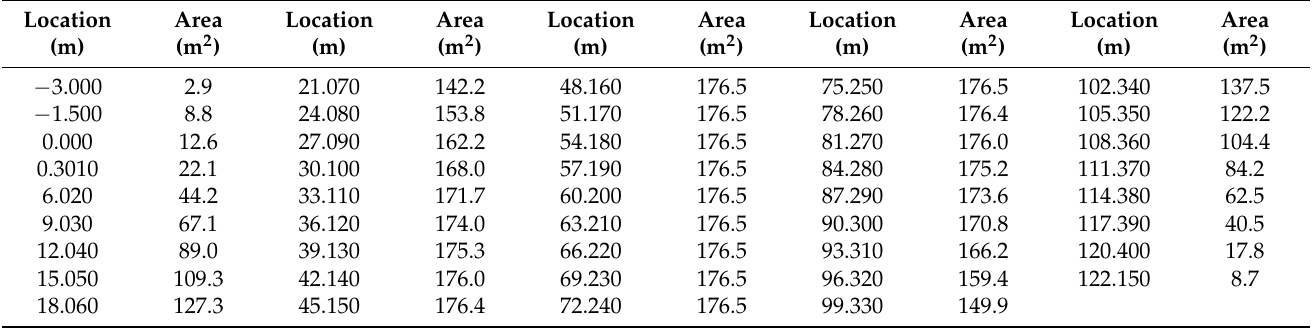
Table 5. The sectional area according to the location of the longitudinal section of the 13 K oil chemical tanker